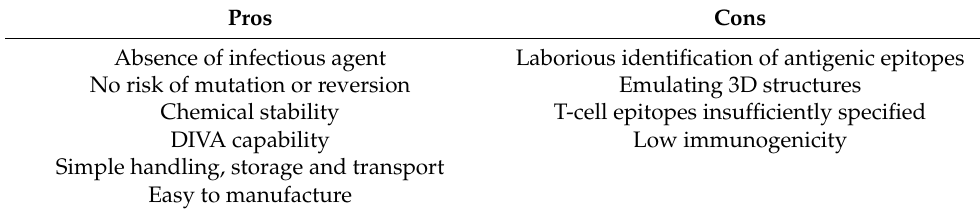
Table 2. Pros and cons of peptide-based vaccines. Pros Cons Absence of infectious agent Laborious identification of antigenic epitopes No risk of mutation or reversion Emulating 3D structures Chemical stability DIVA capability Simple handling, storage and transport Easy to